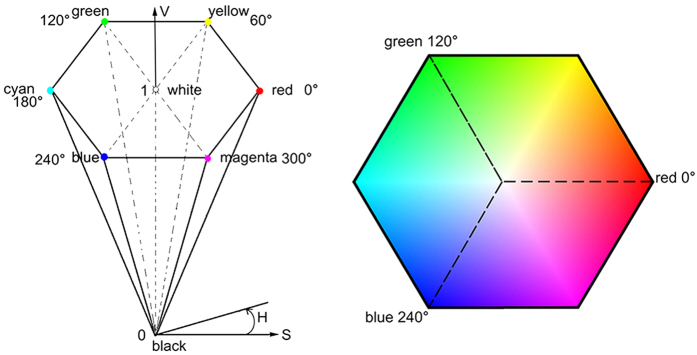
HSV hexahedral cone.